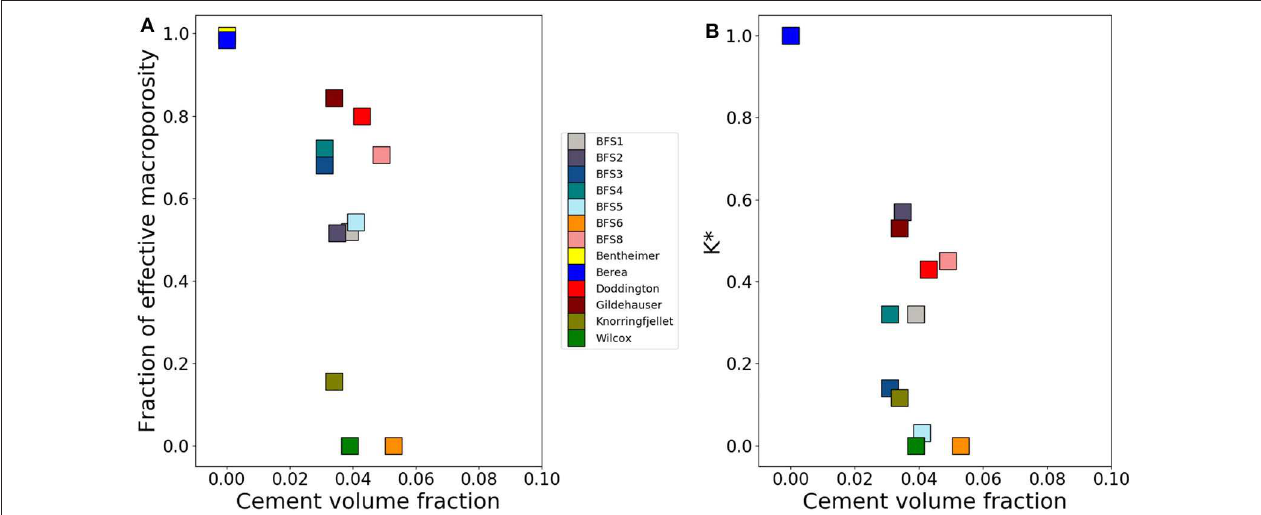
FIGURE 6 | Plots displaying the fraction of effective macroporosity (A) and the ratio of macro permeability and total permeability (B) as a function of cement volume